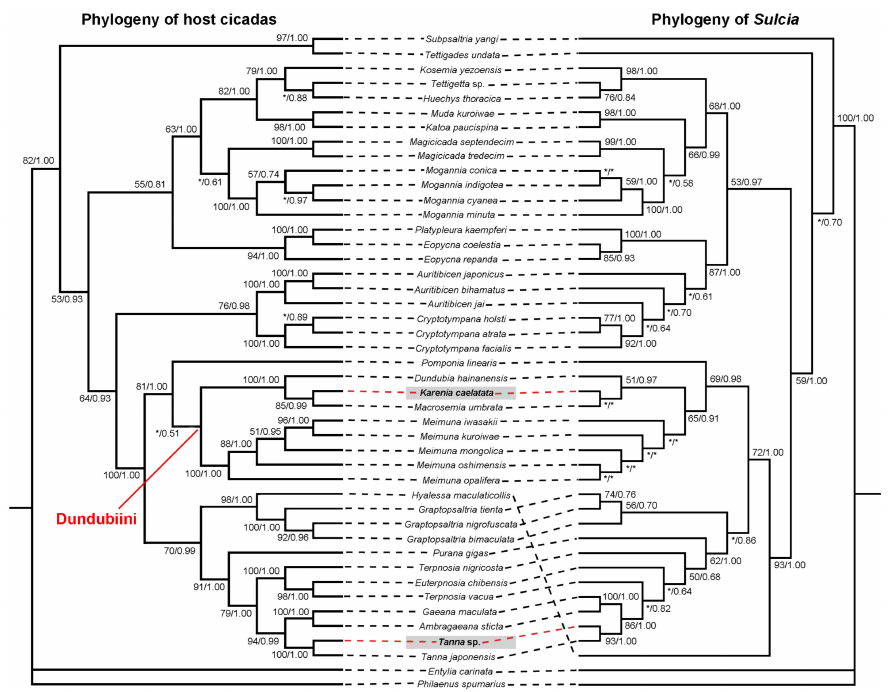
Figure 7. Co-phylogeny of host cicadas and Sulcia . The phylogenetic relationship of host cicadas was reconstructed based on joint mitochondrial genes ( COI + COII + Cytb ). The phylogenetic relationship of Sulcia was reconstructed based on 16S rRNA gene sequences. Asterisks (“*”) representing support values less than 50% and bootstrap support values more than 50% are shown on each node in the order of the maximum-likelihood/Bayesian inference. Bootstrap support values and posterior probabilities of the maximum-likelihood/Bayesian inference are shown near branches.